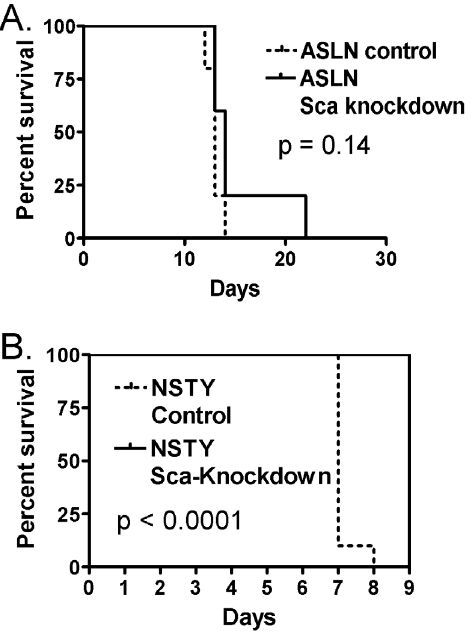
Figure 3. Comparison of in vivo survival between control and Ly6a/Sca-1 knockdown leukemias. Mice were injected iv with 1 6 10 6 leukemia cells and monitored daily for survival. ‘‘Control’’ were leukemia lines transduced with a control lentiviral vector containing only a puromycin resistance gene, while the ‘‘Sca-knockdown’’ had been transduced with a lentivirus containing an anti-Ly6a/Sca-1 sequence as well as the puromycin resistance gene. (A) ASLN leukemia. N5 per group. Control group had median survival of 13 days, while Sca- 1 knockdown had median survival of 14 days. P0.14 by logrank test. (B) NSTY leukemia. N10 per group. Control group had median survival of 7 days while the Sca-knockdown had median survival of 9 days. P , 0.0001 by logrank